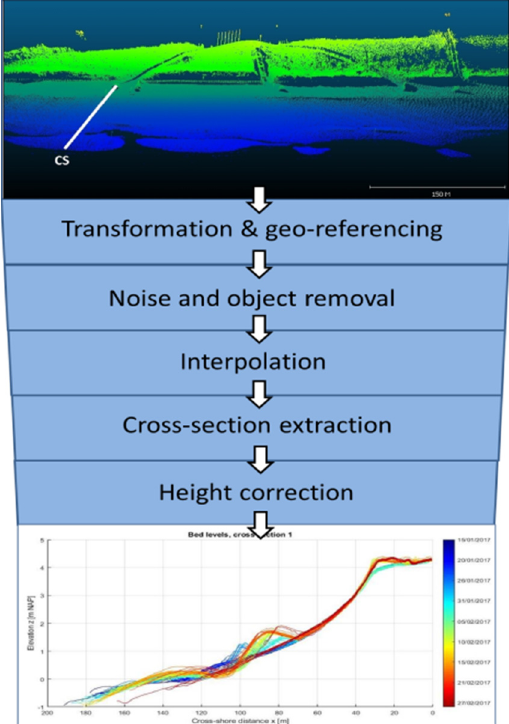
Figure 3 . Data processing steps. The letters CS in the top of the image indicate the location of the cross-section (see also Figure 2).